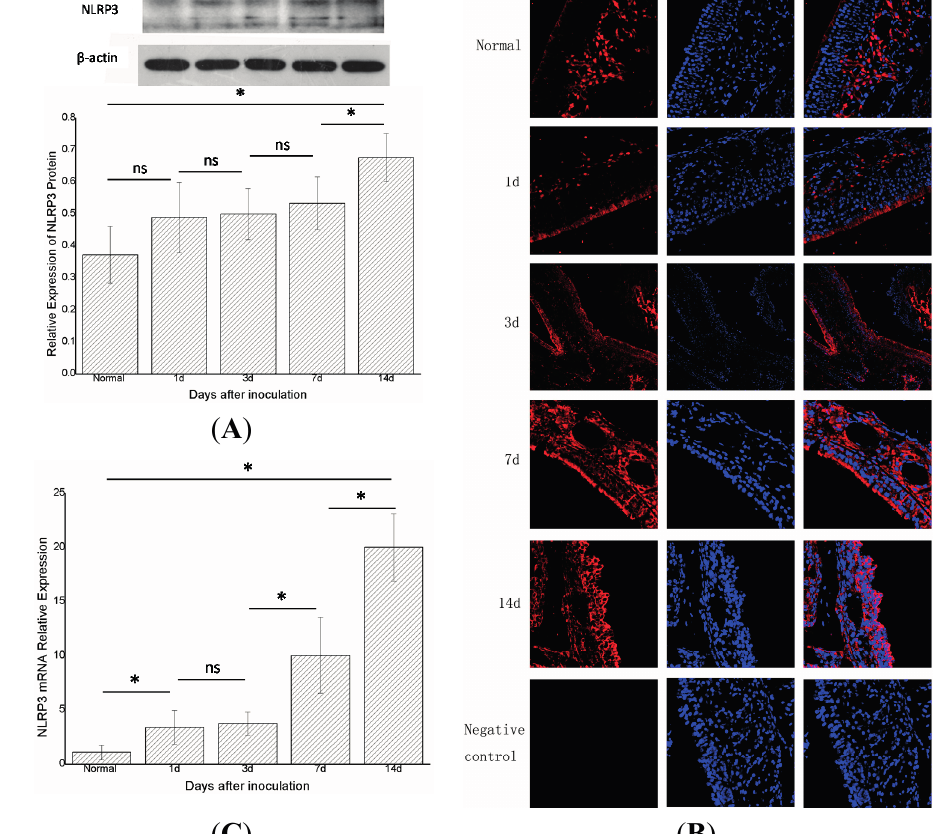
Figure 3. The expression of total NLRP3 protein and NLRP3 mRNA in the right nasal mucosa of mice. ( A ) Western blot assessment of the protein expression of NLRP3 in the control group (group A), and 1, 3, 7, and 14 days (groups B, C, D, and E, respectively) after stimulation with S. aureus . A semi-quantitative analysis was used to represent the total protein level of NLRP3; ( B ) Immunofluorescence showed that NLRP3 was mainly expressed in the cytoplasm of cells in the nasal mucosa; and ( C ) Real-time PCR assessment of the mRNA expression of NLRP3 in the control group (group A), and 1, 3, 7, and 14 days (groups B, C, D, and E, respectively) after stimulation with S. aureus (* indicates p < 0.05; ns = not statistically